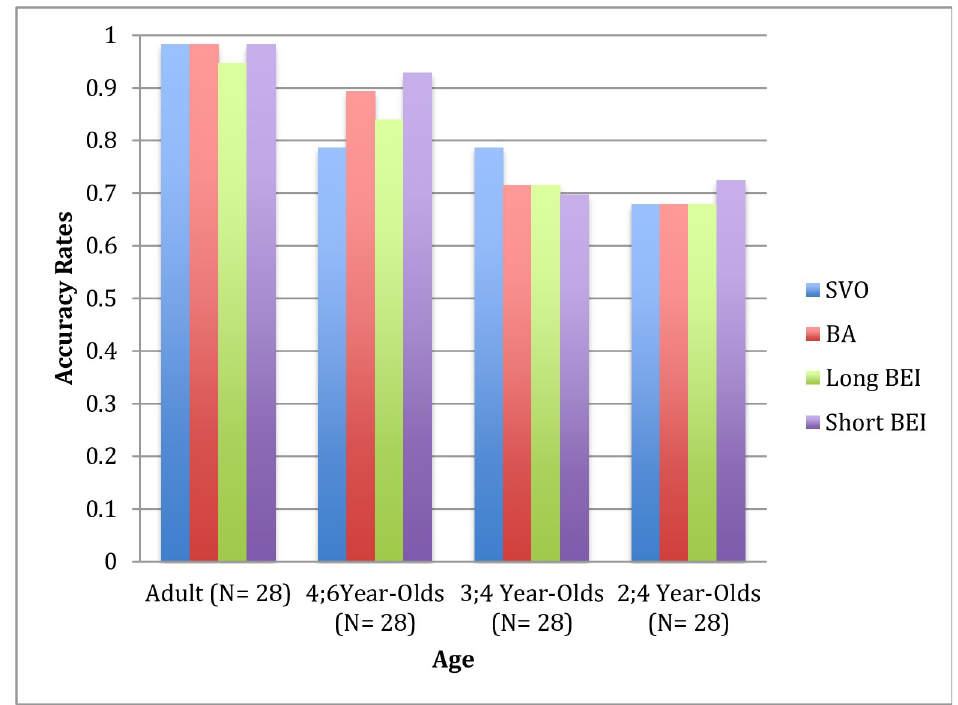
Fig 2. Mean proportions of identifying the correct agent as a function of age and construction